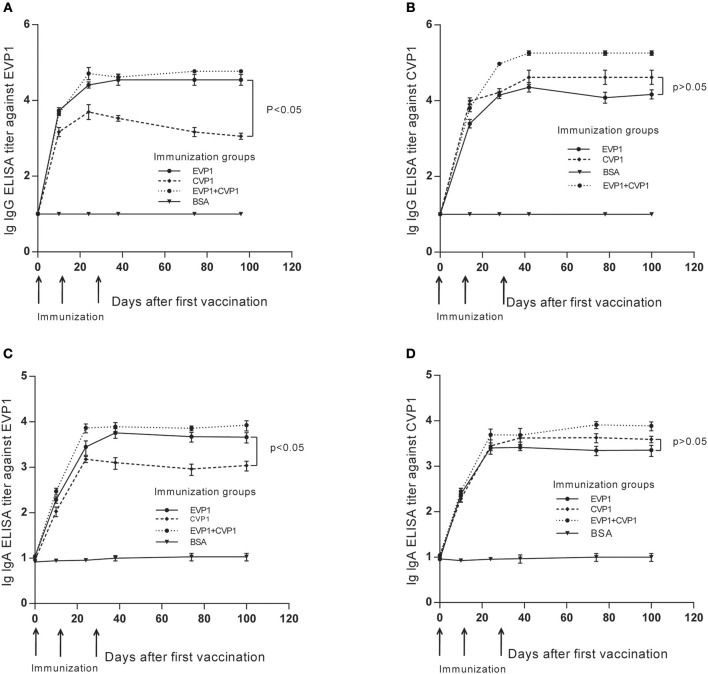
Titers of total IgG and secretory IgA antibodies in the three immunized groups of BALB/C mice changing course detected by EVP1 and CVP1. (A) Titers of total IgG in the three immunized groups of BALB/C mice changing course detected by EVP1. (B) Titers of total IgG in the three immunized groups of BALB/C mice changing course detected by CVP1. (C) Titers of secretory IgA in the three immunized groups of BALB/C mice changing course detected by EVP1. (D) Titers of secretory IgA in the three immunized groups of BALB/C mice changing course detected by CVP1. Different symbols represent different immunized groups: EVP1 recombinant protein-immunized group is represented by the black circle; CVP1 recombinant protein-immunized group is represented by the diamond, EVP1+CVP1-immunized group is represented by the star, and the control group immunized with BSA is represented by the inverted triangle. The p-value of the statistical analysis in each subtype was marked.